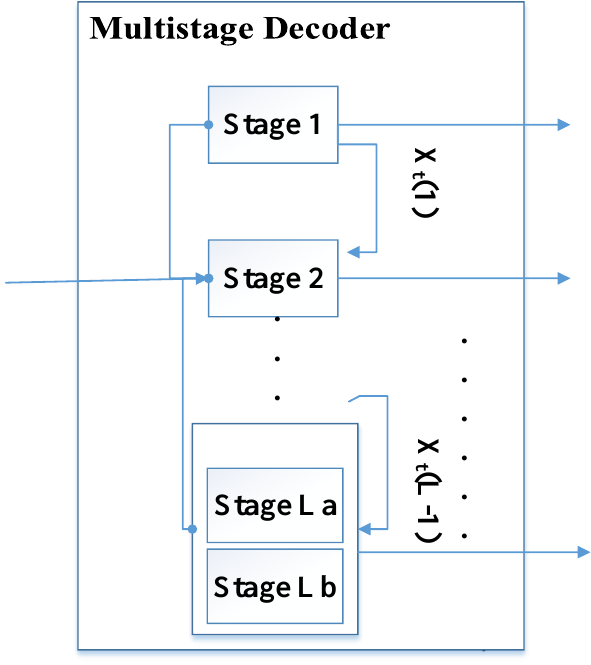
Figure 1. Multistage decoder.